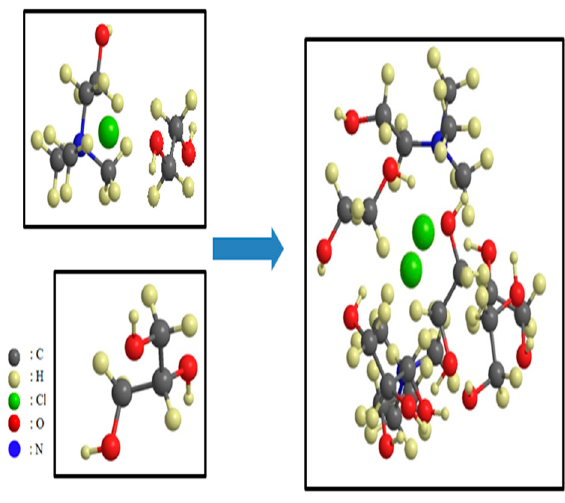
Figure 2. Conductivity and viscosity of the DESs at 25 °C without and with FeCl 3 ·6H 2 O.